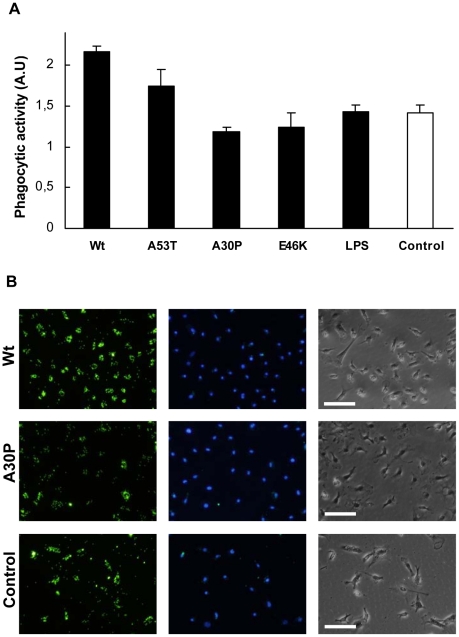
Effect of α-Syn-stimulation on microglial phagocytosis.(A) After treatment of the primary microglial cell cultures
with α-Syn (1 µg/ml) for 20 hours, cells were
incubated with fluorescent microspheres for 1 hour. After fixing the
cells, phagocytosis was assessed by fluorescence microscopy analysis.
The phagocytic index was calculated by dividing the fluorescence from
the phagocytosed microspheres by the total number of cells in the
images. Four images were analysed for each sample in each experiment,
and the results shown are representative of three independent
experiments. A.U.: arbitrary units. (Representative microscopy images
used to determine the phagocityc activity of microglial cultures
stimulated with Wt (top) an A30P (centre) α-Syn, or non
stimulated microglial cells (bottom). From left to right, green
fluorescent microspheres, Hoechst-stained cells, and cells as observed
in the absence of fluorescence. Scale bar: 50 µM.